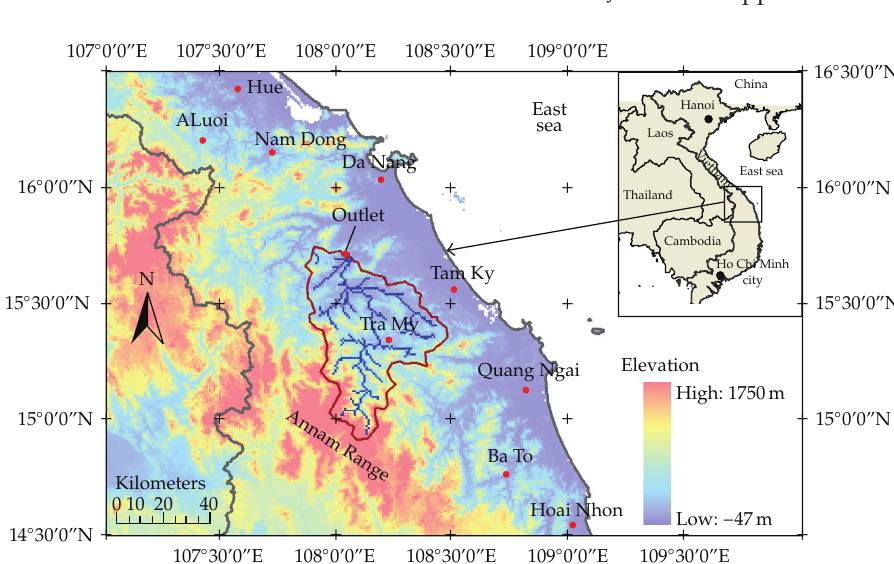
Figure 1: Location of study area and weather observation points (cid:2) • (cid:3)